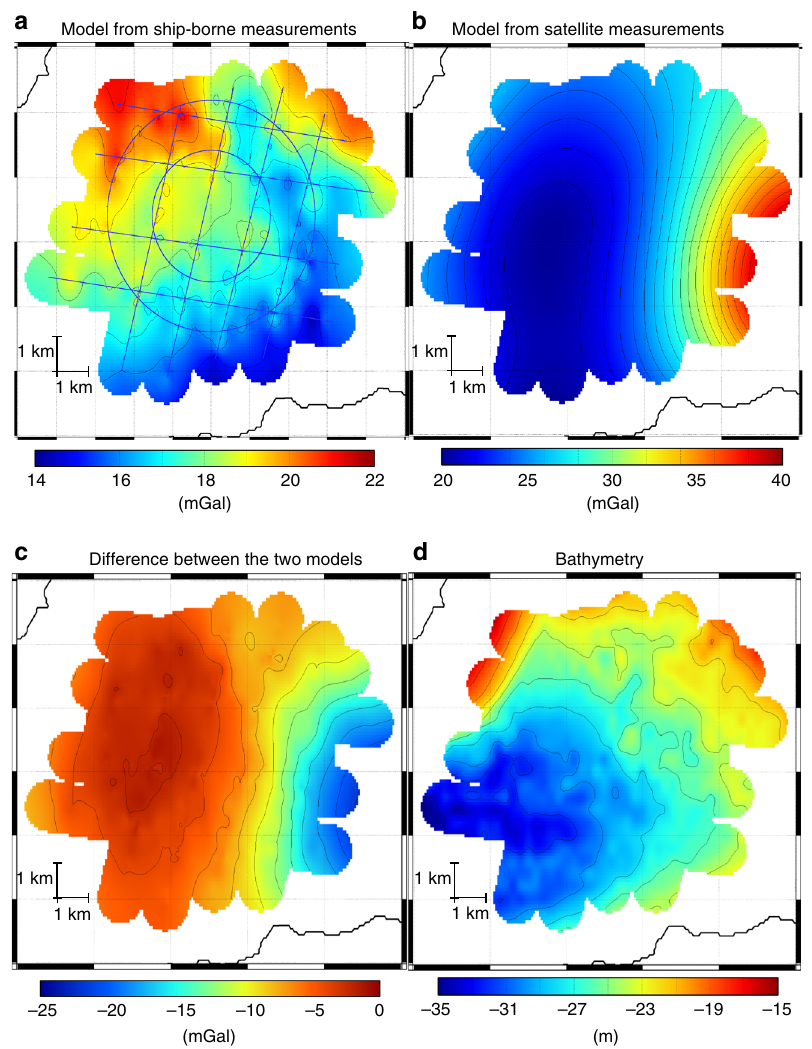
Fig. 6 Gravity anomaly model of Douarnenez bay. a Model obtained from ship-borne atom gravimeter measurements. The blue lines are the pro fi les on which the gravity was measured. b Model obtained from satellite measurements 1 (Sandwell v24). c Difference between the ship-borne model and the satellite model. d Bathymetry for comparison with gravity